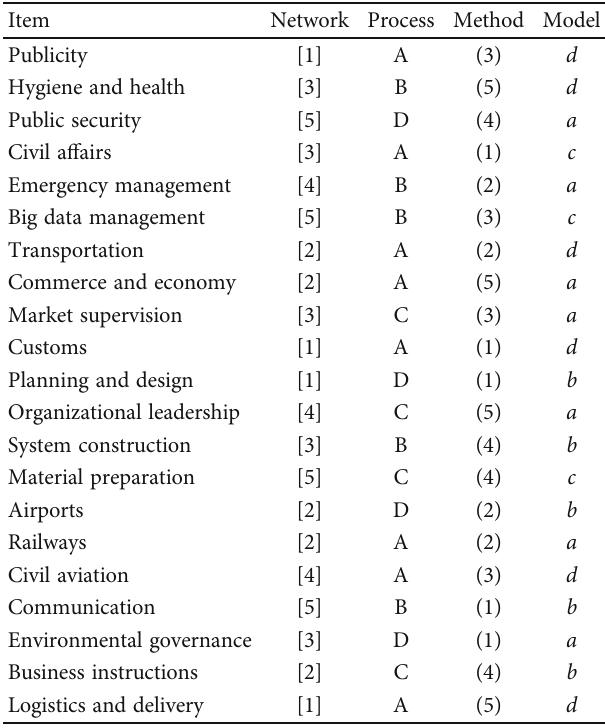
Figure 3: Resource allocation method in public administration and resource allocation based on blockchain and structured occupational therapy. Table 2: Role of distributed ledger to increase the information symmetry of public administration